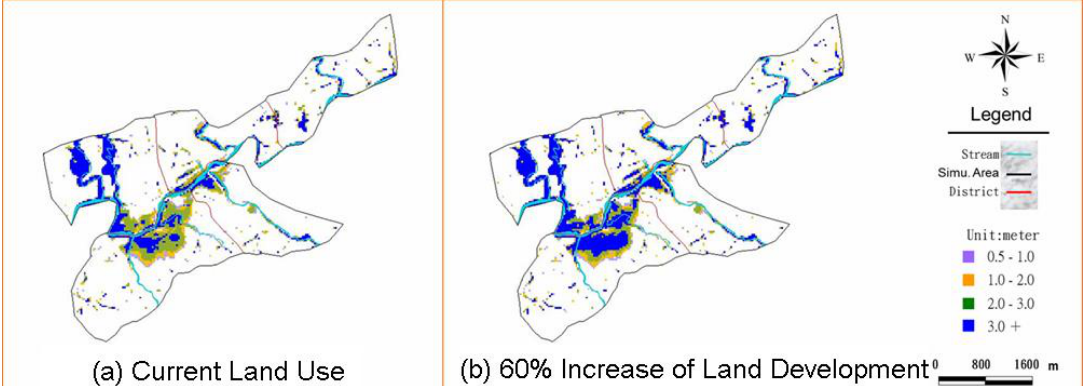
Figure 4. 200-year return period Precipitation Conditions: Flood Simulation of Current Land Use vs. 60% Increase of Land